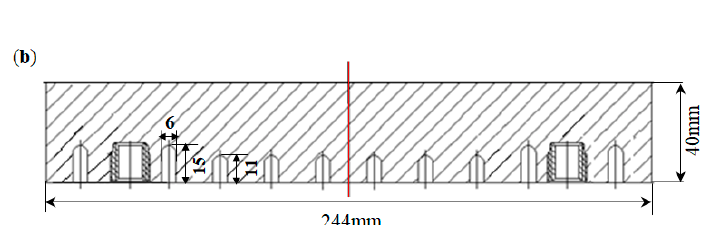
Figure 4. The narrow face of mold. ( a ) The narrow face of chamfered mold; ( b ) The narrow face of common mold.